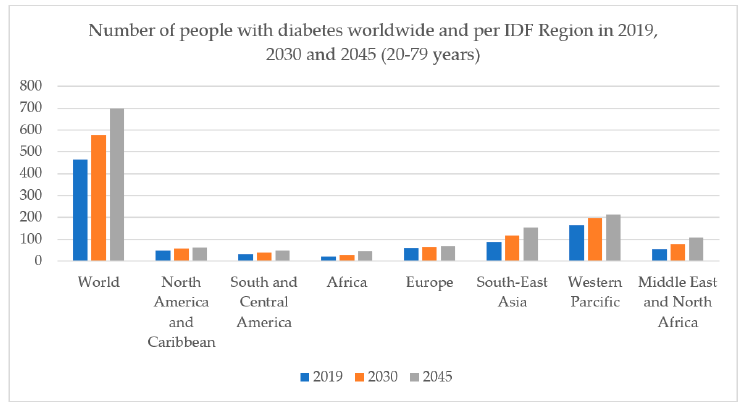
Figure 1. Number of people with diabetes worldwide and per International Diabetes Federation (IDF) region.